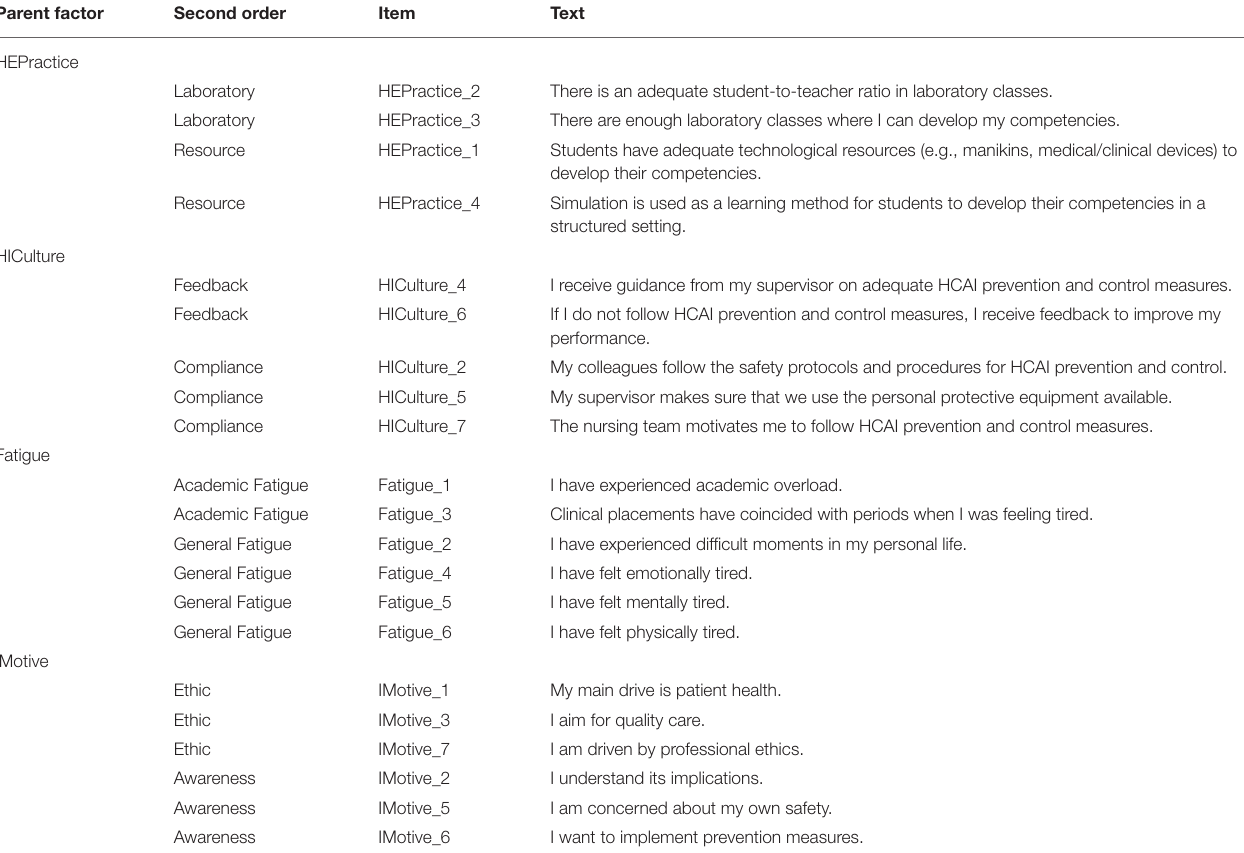
TABLE 5 | Second-order factors.